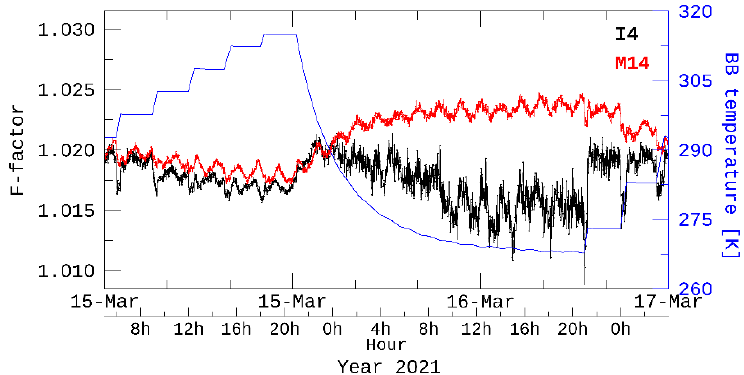
Figure 8. S-NPP VIIRS bands I4 (detector 16, Product Order) and M14 (detector 8, Product Order) F-factors and BB temperature during WUCD event performed from 15 March to 17 March 2021. Values shown are granule-averaged. Only the F-factors for HAM-side A are illustrated. The M14 F-factors were shifted upward by 2.75% so that these can be in the same range as the I4 F-factors.